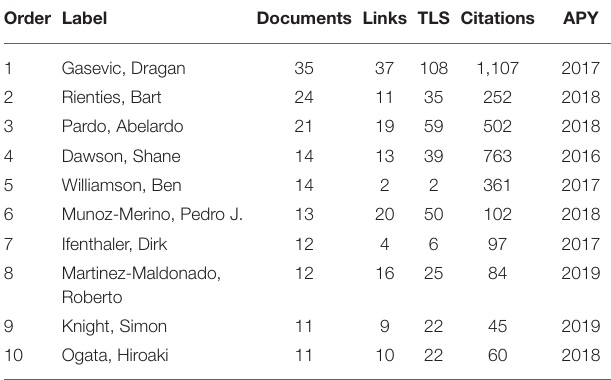
TABLE 5 | The top 10 strongest co-authorship. Order